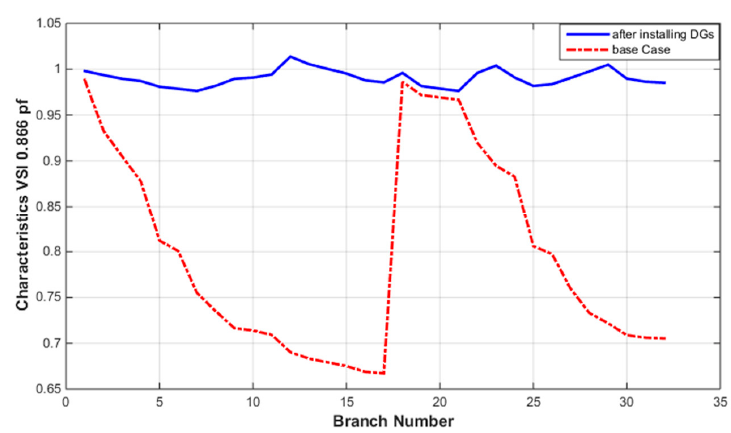
Figure 15. Characteristics of bus voltages, 33-bus system at 0.866 pf.